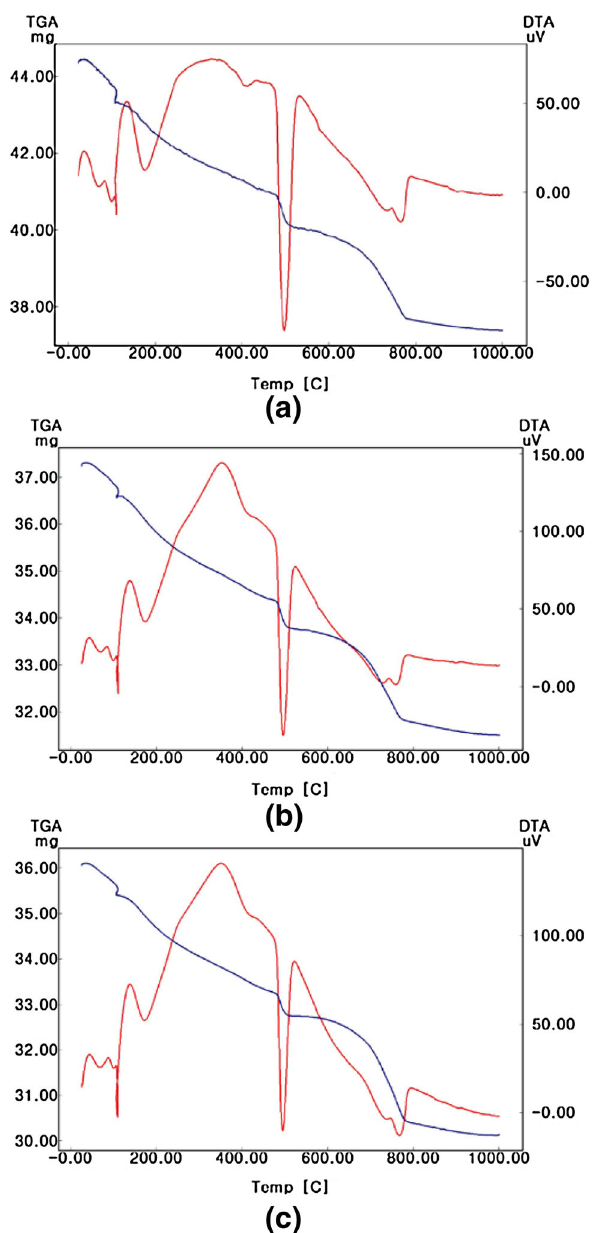
Fig. 4 Mortar TG/DTA (28 days). a mortar using NFA (28 days), b mortar using RFA (28 days), and c mortar using Modified RFA (28